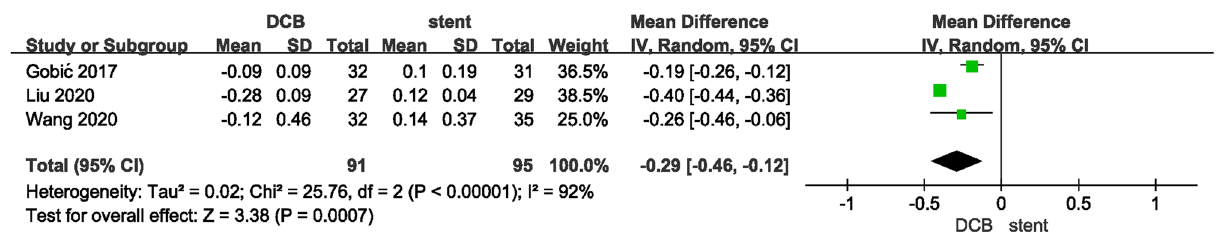
Figure 4. Risk Ratio (RR) of late lumen loss